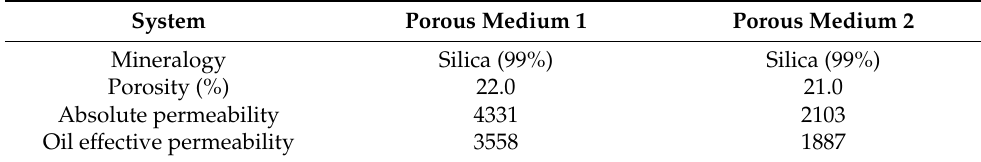
Table 6. Basic characteristics of porous